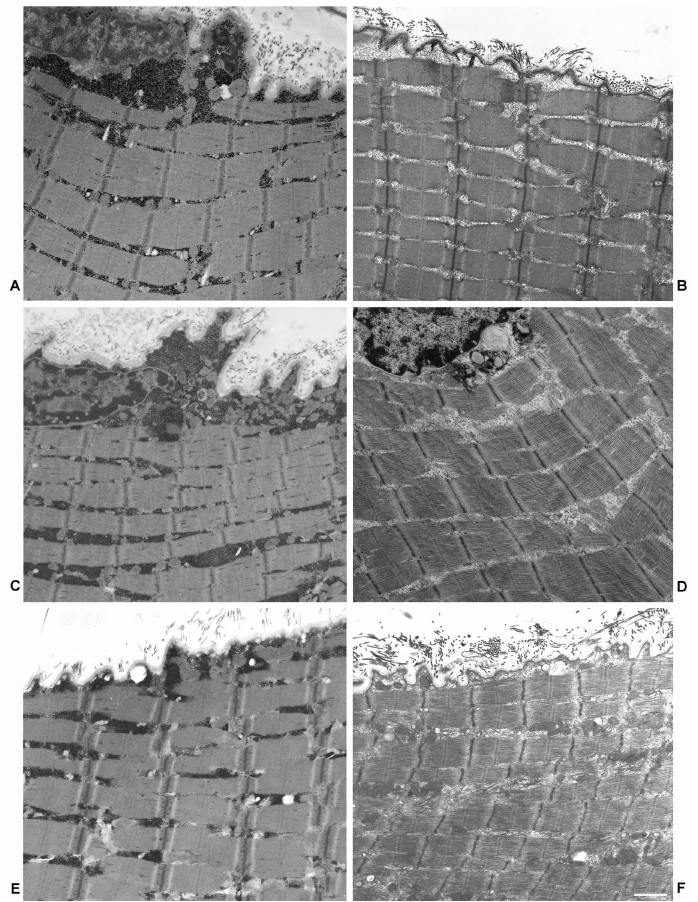
Figure 2. Electron microscopy of muscle fibers in longitudinal section of three Pompe disease patients. ( A , C , E ) are from pre-treatment patients. Massive glycogen accumulations are evident both in the cytoplasm immediately beneath the plasma membrane and in the intermyofibrillar spaces. ( B , D , F ) Micrographs from the same patients after treatment show a relevant glycogen reduction. Bar = 1.5 µ